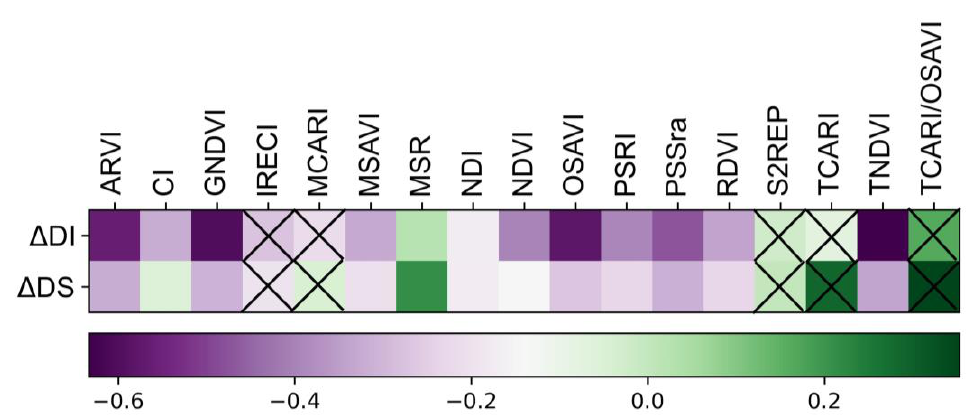
Figure 9. Relationship between ΔDI, ΔDS , and the temporal rate of change in VI. The range co-domain of the correlation coefficients is shown in the color bar. (X) symbols represent non-significant relationships ( p ≥0.001).